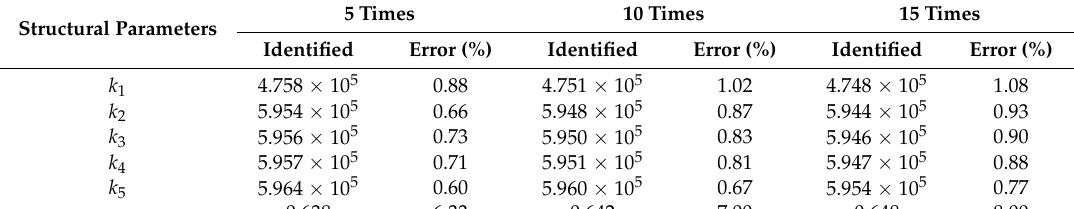
Table 3. The identified parameters with different initial values.